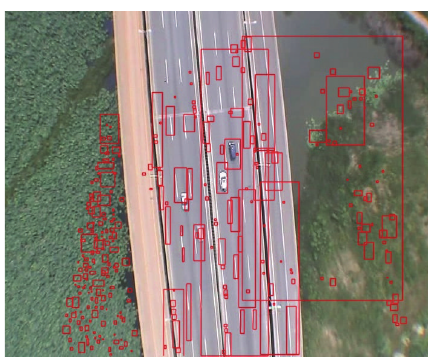
Figure 8: Hardware used in the